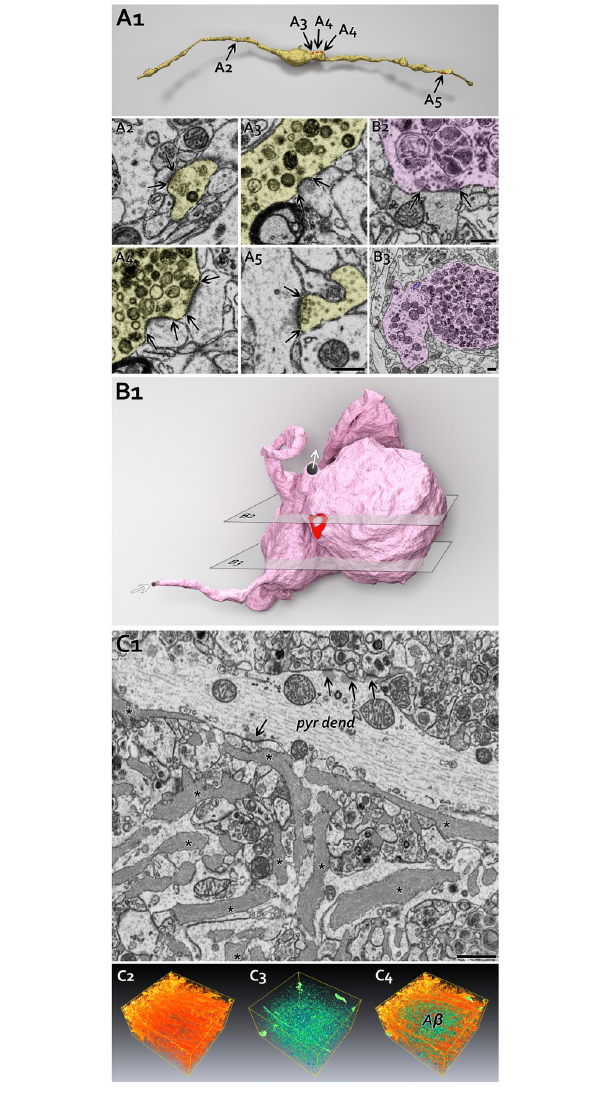
Fig 3. Subcellular structural alterations in dystrophic axons in APP NL-F mice. A: 3D reconstruction of a mildly dystrophic axon (A1, yellow: axon, red: synapses). Black arrows indicate synapses, some of which are shown enlarged as well (A2-A5). Intracellular compartment accumulation (electron-dense dark material) around A3 and A4 synapses is clearly visible (on the 3D model: bulging middle part). Distant synapses (A2, A5) from the bulging part display seemingly normal morphology. (S2 Fig shows the surrounding tissue.) Scale bar: 500 nm. B: A balloon-like dystrophic axon (B1, pink: axon, red: synapses, white arrows indicate the axonal ends of this segment). B2, B3 show two representative section planes. Dystrophic axon generated three, almost detached balloons: one filled with normal looking but smaller mitochondria (main part, B3 left), the two others are filled with electron-dense degrading mitochondria and other cellular organelles (B3 right). Bulging dystrophic balloon has a perforated-like synapse that escaped microglial elimination (B2). Mitochondria seem to be transferred between balloons (B3, purple mitochondria). Scale bars: 500 nm. C: Filamentous A β accumulation (asterisks) around synapses in the stratum radiatum in hippocampus CA1 (C1). Arrows indicate synapses on pyramidal cell dendrite (pyr dend). C2-C3 shows 3D volume rendering from stratum radiatum. Pyramidal cell dendrites are orange-red colored (C2), whereas electron- dense dystrophic particles (auto-phagosomes, lysosomes, small, degrading mitochondria) colored teal (C3). Scale bar 1 μ m. (Also see S2